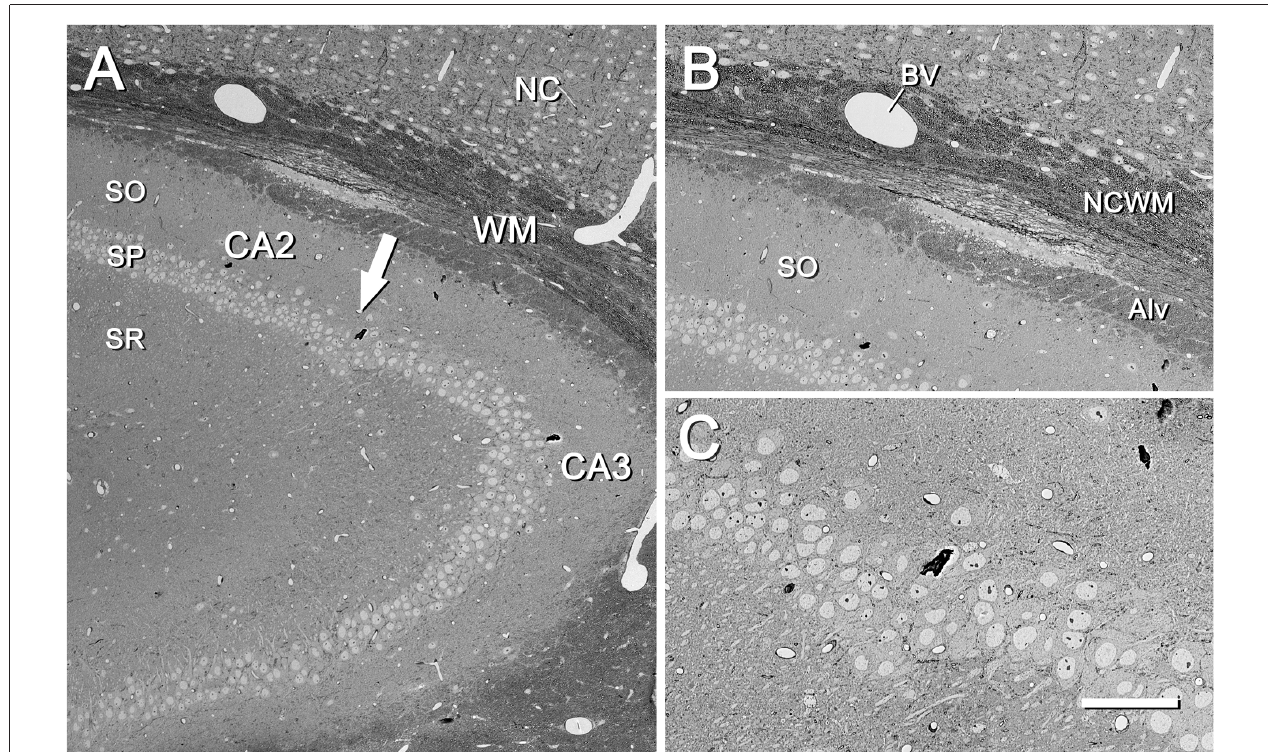
FIGURE 3 | CA2/CA3 region of the mouse hippocampus. (A) CA2/CA3 regions corresponding to the inset “a” of Figure 2 . SO, stratum oriens; SP, stratum pyramidale; SR, stratum radiatum; NC, neocortex; WM, white matter. The arrow points to the boundary between CA2 and CA3. The original image was acquired with the SE2 detector at 70 × (resolution 792.2 nm/pixel), with an acceleration voltage of 8.00 kV. (B) Higher magnification of the same region shown in (A) , where differences in the architectural features of the fascicles of fibers can be seen between the neocortical white matter (NCWM) and the alveus (Alv). SO, stratum oriens; BV, blood vessel. The original image was taken with the SE2 detector at 204 × (273.4 nm/pixel), accelerating voltage of 8.00 kV. (C) Higher magnification of the SP at the boundary between CA2 and CA3. Original image acquired with the SE2 detector at 400 × (139.6 nm/pixel), accelerating voltage of 8.00 kV. Calibration bar: 140,100 and 50 µ m for (A) , (B) and (C)